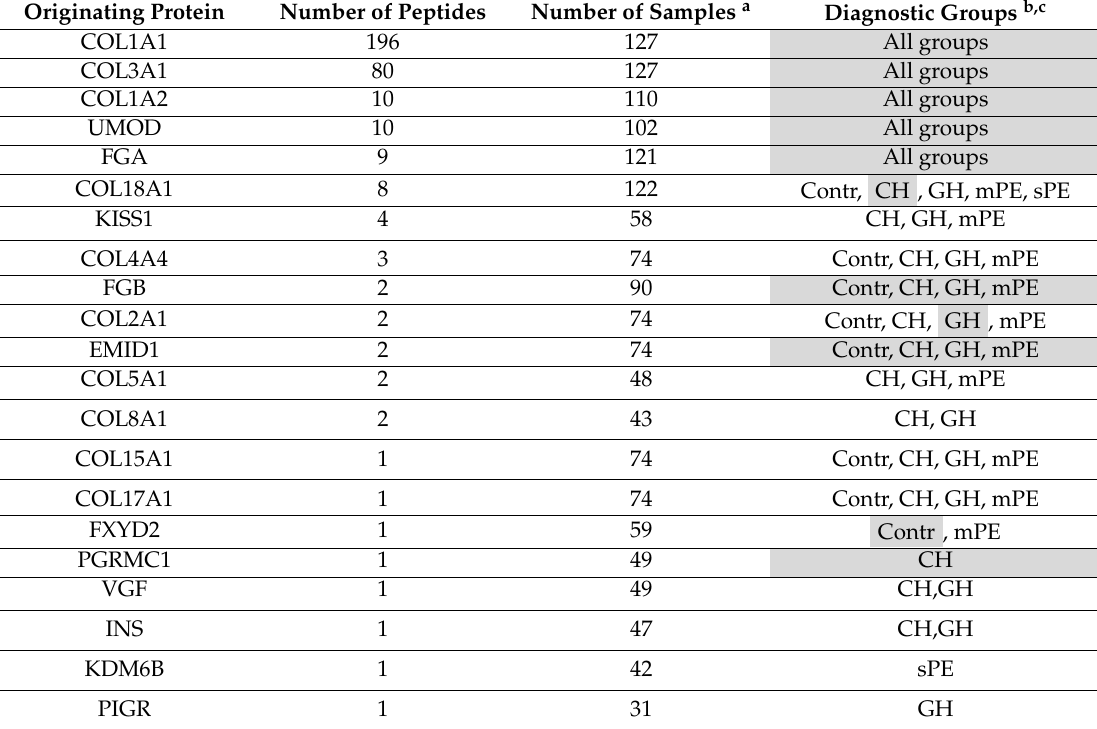
Table 2. Number and origin of substantially represented peptides in urine of pregnant